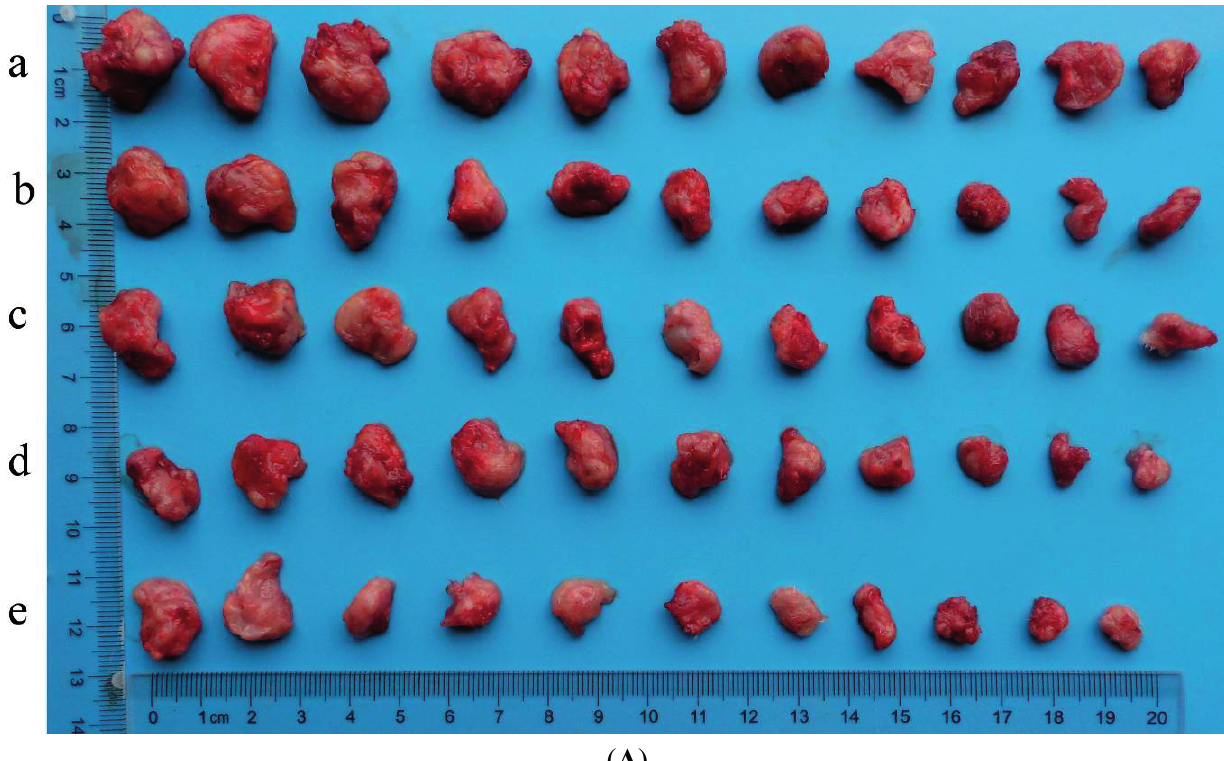
Figure 3. Inhibitory effect of 8-acetamino-isocorydine ( 11 ) on murine hepatoma H mice. ( A ) Photograph of the tumors excised from H22-bearing mice (a, blank control group; b, 50 mg/kg group; c, 100 mg/kg group; d, 200 mg/kg group; e, CTX group).